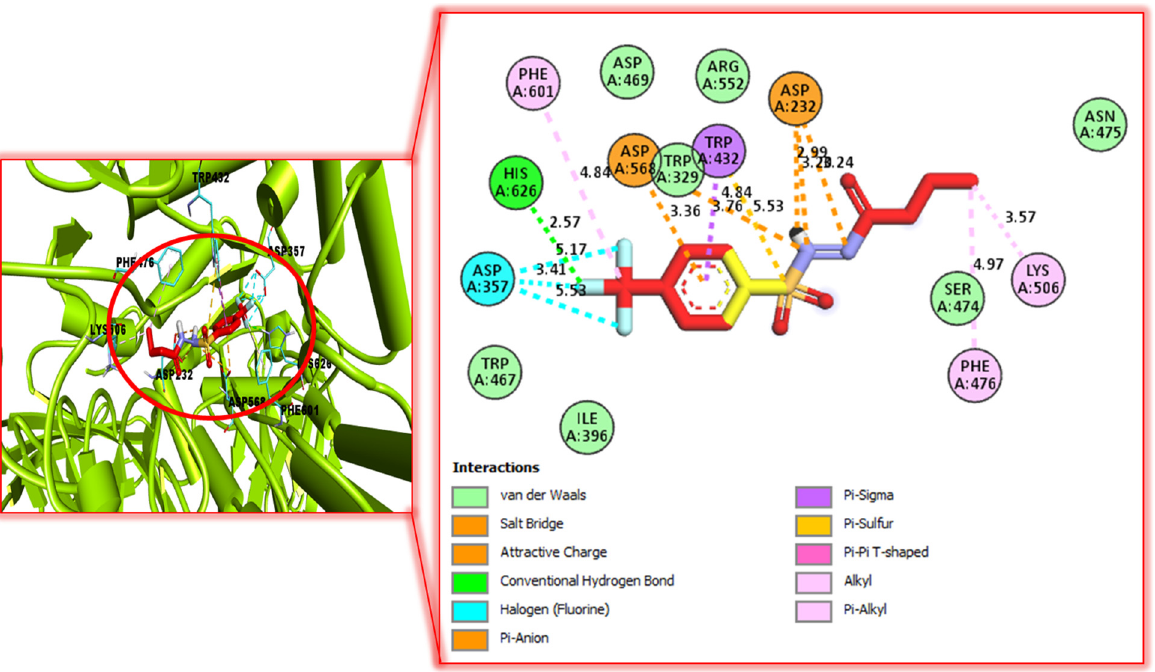
Figure 5. Protein–ligand interaction profiles for active analog against α -Glucosidase represent the surface of the corresponding enzyme. The PLI profile for compound 6